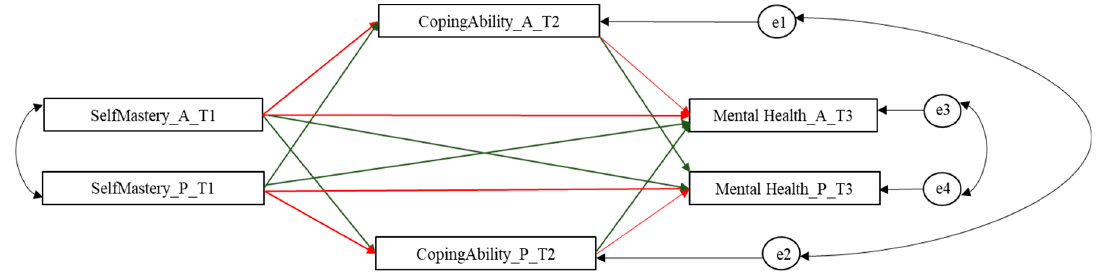
Figure 1. Theoretical model tested. Note: SelfMastery = Self-Mastery; CopingAbility = perceived coping ability to manage stress event-related; Mental_Health = Mental Health; A = adolescent; p = parent. Red lines indicate actor effects; green lines indicate partner effects.